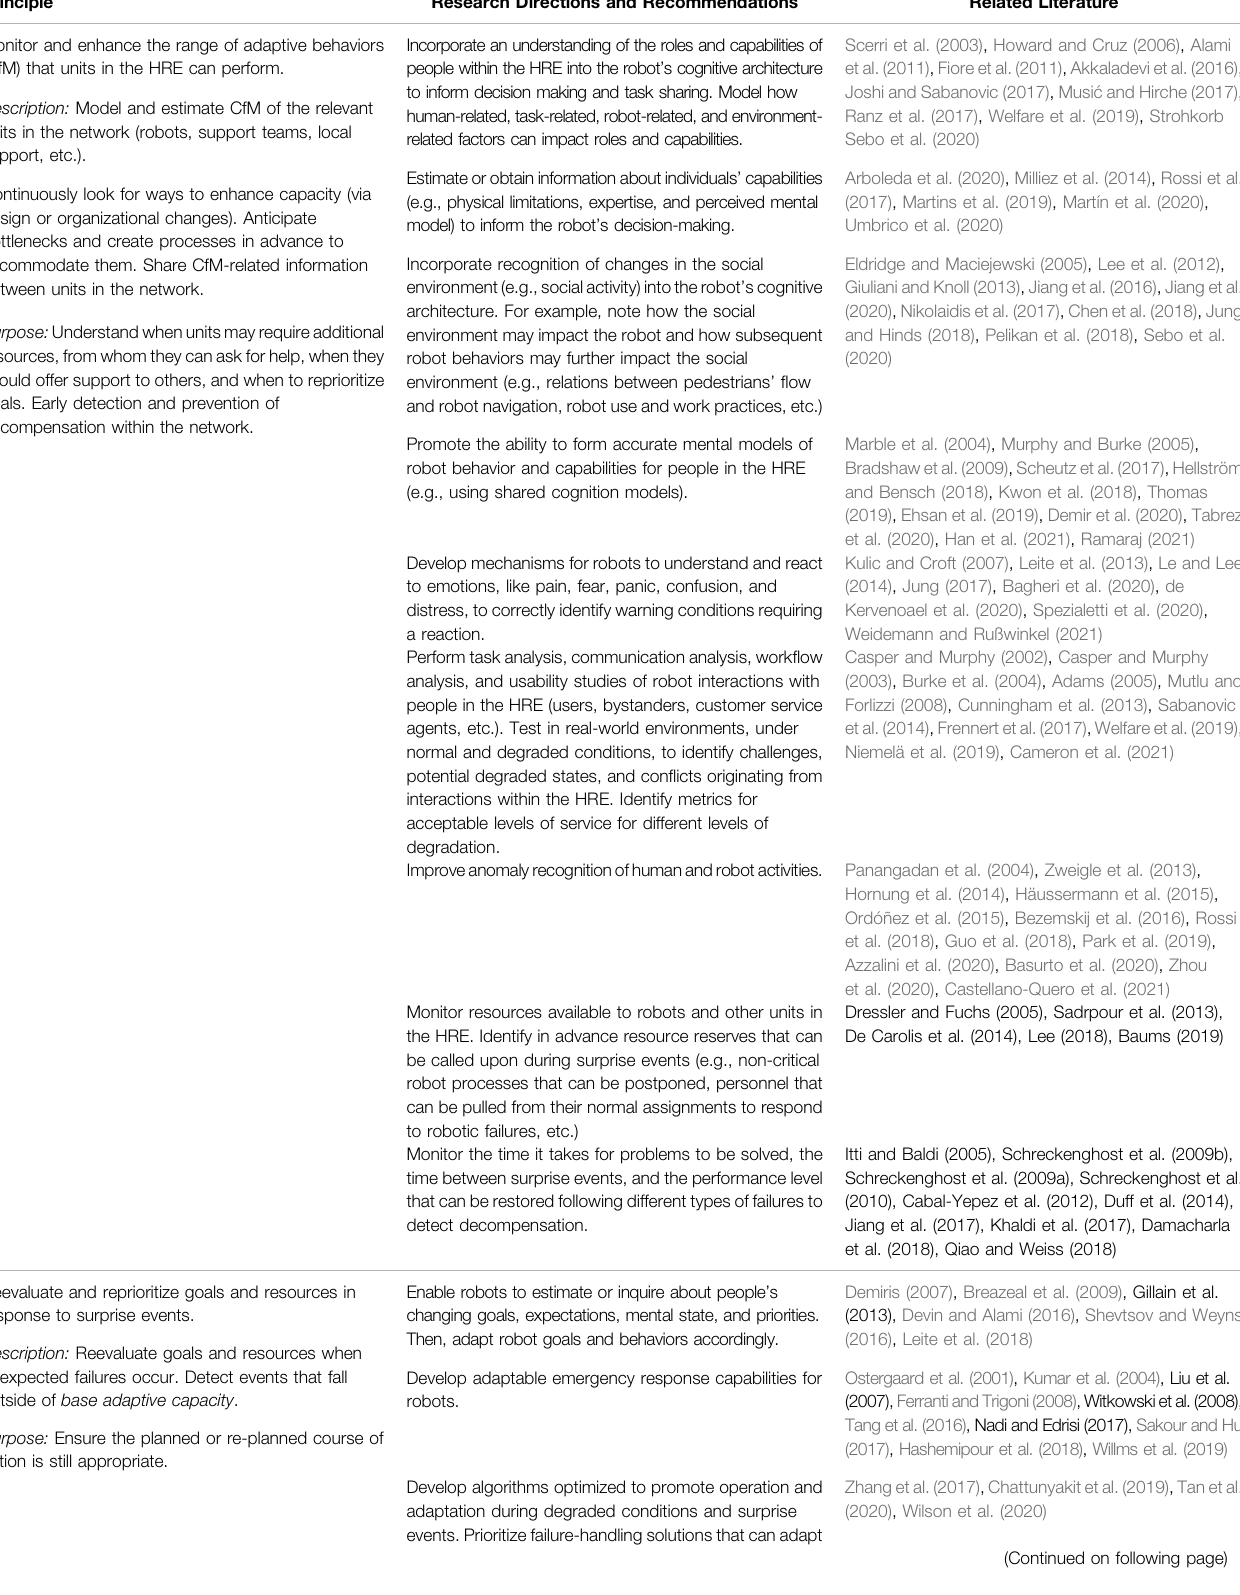
TABLE 1 | Socio-technical considerations for handling unexpected failures that challenge the human-robot ecosystem. Principle Research Directions and